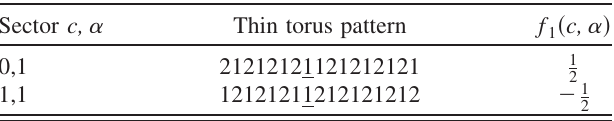
TABLE III. Thin torus patterns for a single-quasihole k ¼ 3 Read-Rezayi state, and the offset functions of the associated domain walls. The latter are fully determined by the inversion symmetry of the state. The orbital positions 2 n Since the sectors are all related by translation, (cid:17) takes on a single